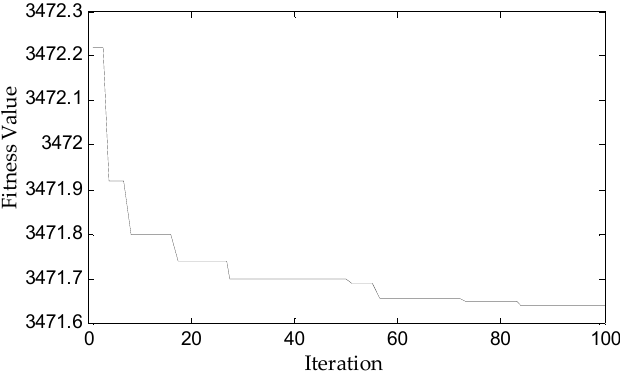
Figure 9. The fitness curve of particle swarm optimization (PSO).